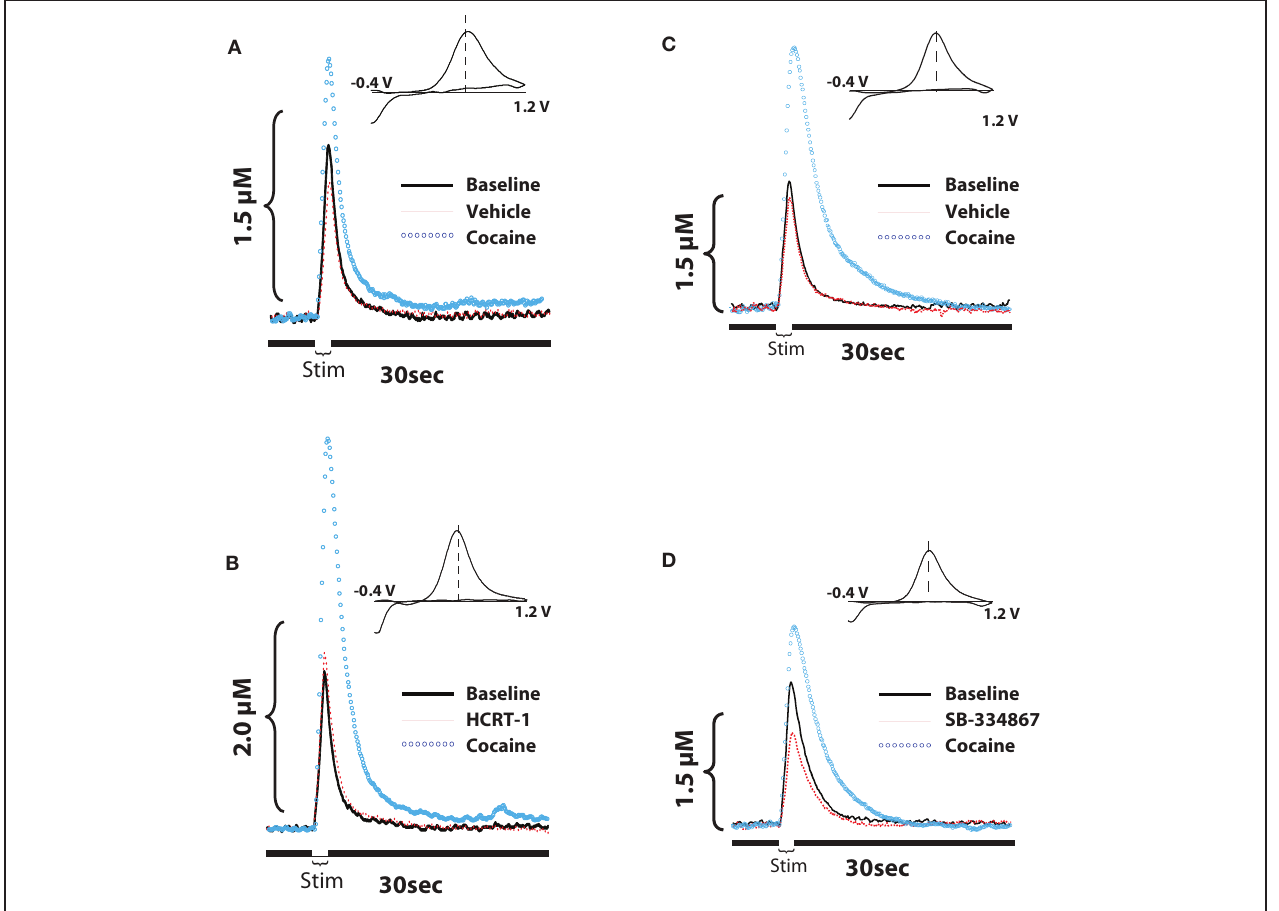
FIGURE 3 | Hypocretin signaling influences cocaine-induced changes in evoked-dopamine release and uptake in the NAc core. (A,B) Shown are representative concentration-time plots and cyclic voltammograms (insets) of dopamine responses from rats that received pretreatment infusions of vehicle or 0.5nmol hypocretin-1 into the VTA. (C,D) Shown are representative concentration-time plots and cyclic voltammograms (insets) of dopamine responses from rats that received pretreatment infusions of vehicle or 10nmol SB-334867 into the VTA. Stim represents the time of electrical